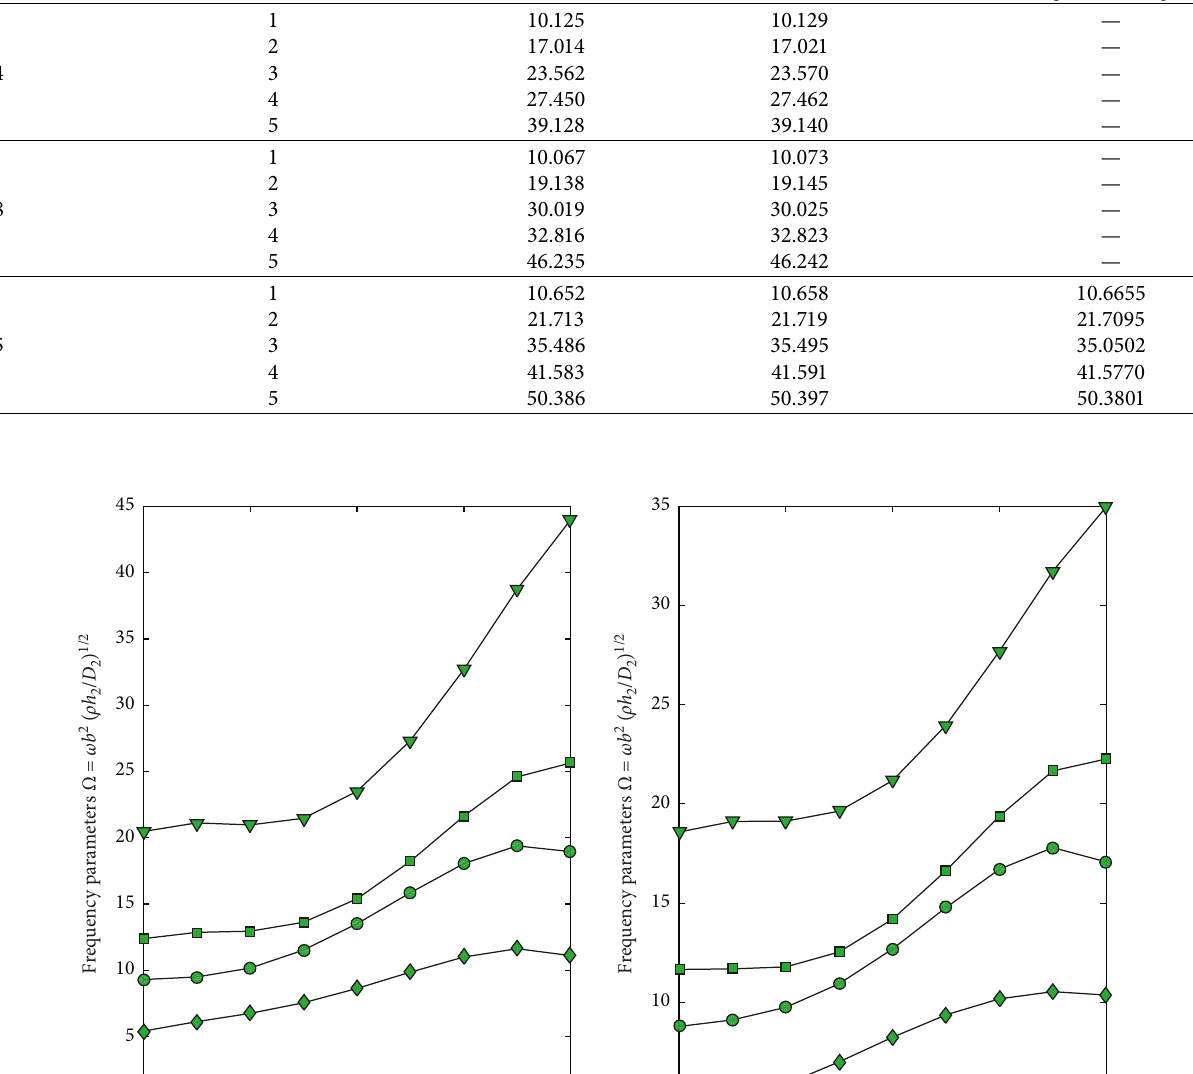
Table 4: Dimensionless frequency parameters with Ω � ω b 2 ( υ � 0 . 3 ) . h 1 / h